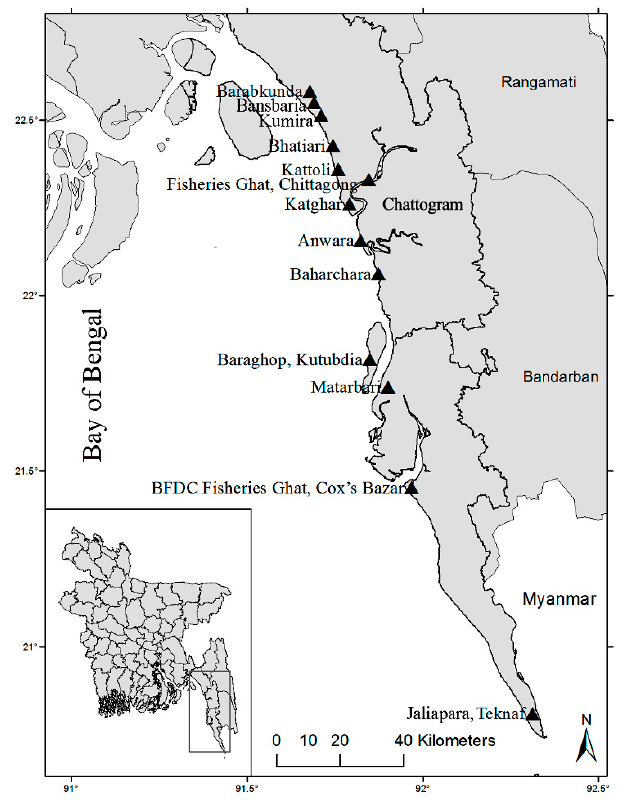
Figure 1. Map of the Bay of Bengal along the south-eastern coast of Bangladesh showing the sampling sites and fish landing centers.